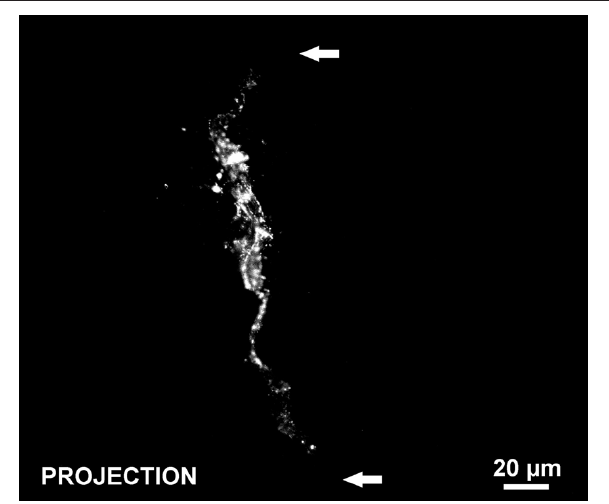
FIGURE 4 | Confocal projection of optical sections throughout the thickness of a PECAM-positive vascular island at day 70 post stimulation. The disconnection of the endothelial cell segment from nearby vasculature is confirmed by the voids in PECAM labeling at either end of the vascular island (arrows).